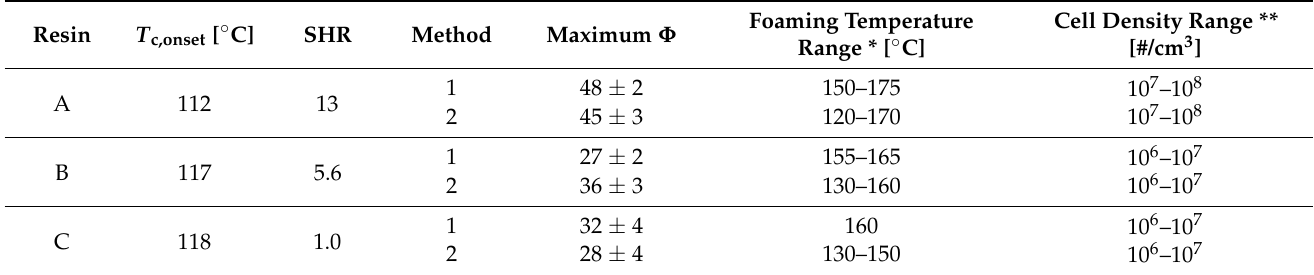
Table 2. Summary of the foamability of three resins subjected to two different batch foaming processes. (Note: * foaming temperature range was determined from conditions that led to Φ > 10; ** cell density range was obtained over the temperature range that led to uniform cell morphology). Units of cell density correspond to number (#) of nucleated bubbles per volume of foamed